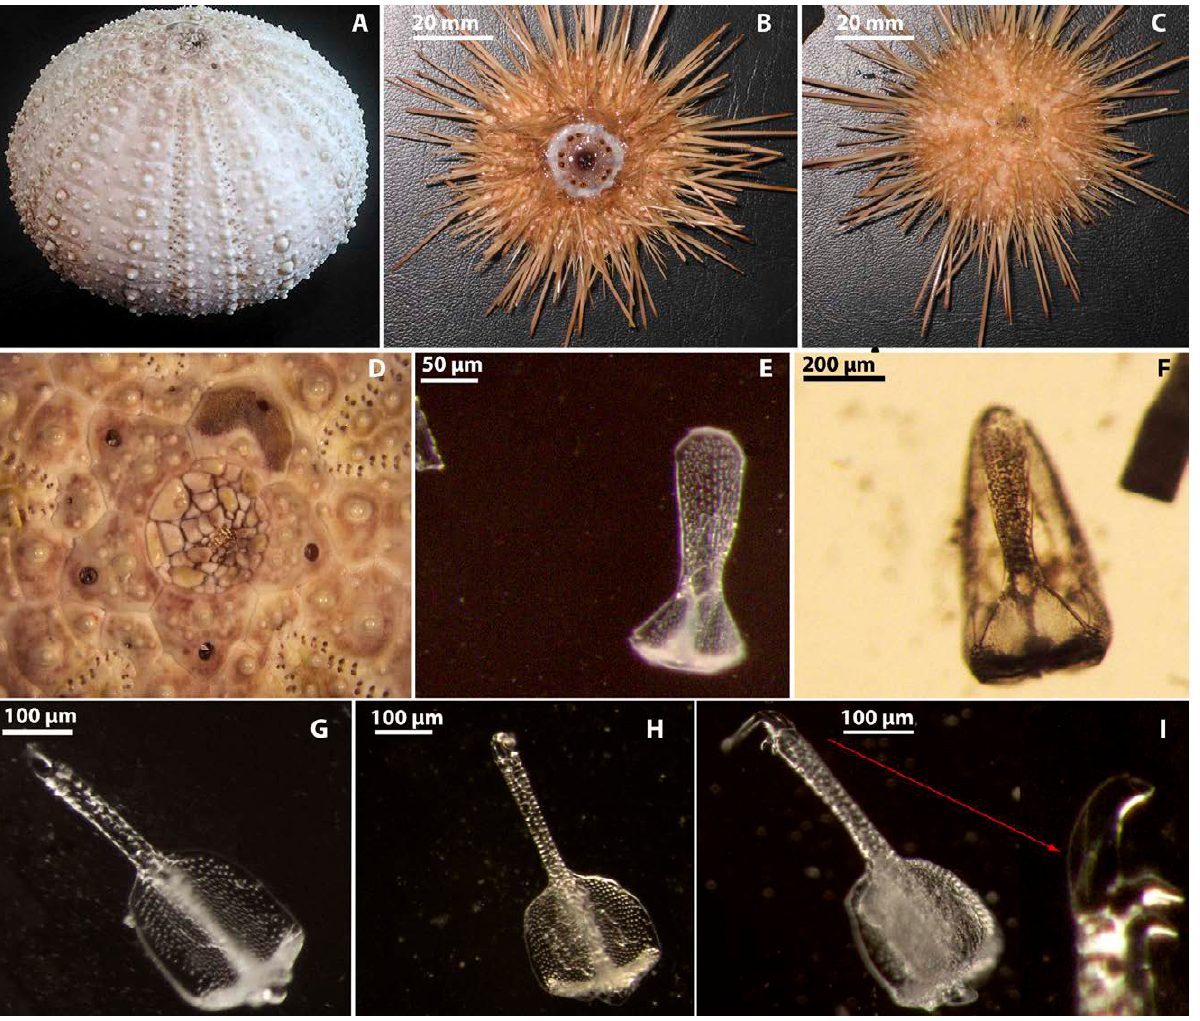
Fig. 5. – Gracilechinus elegans . A, test; B, oral view; C, aboral view; D, periproct structure; E, F, tridentate pedicellariae; G, H, globiferous pedicellariae; I, globiferous pedicellariae, detail of teeth.